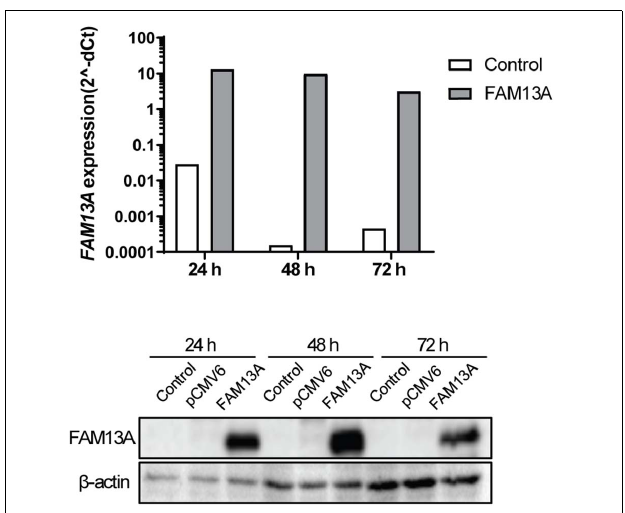
FAM13A mRNA expression levels were measured by qPCR, corrected for the housekeeping genes B2M and PPIA and normalized to control (2 − (cid:49) Ct ). FAM13A protein expression levels were measured using western blot. β -actin was used as the loading control. A representative blot is